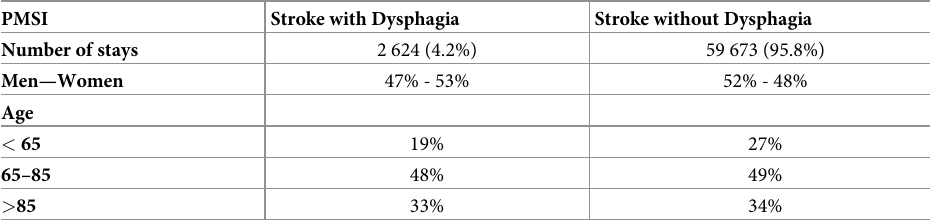
Table 1. Characteristics of stroke patients with dysphagia vs. without dysphagia in